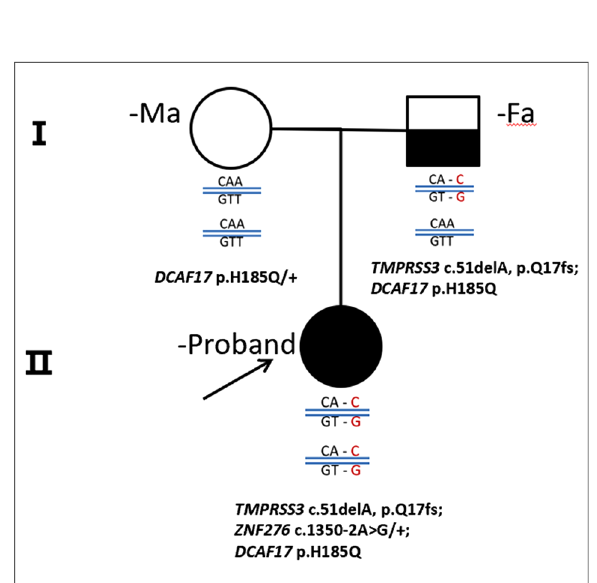
FIGURE 2 A pedigree drawings of the family with non-syndromic hearing imparemt. The proband ’ s parent showed Normal hearing audiograms, while the affected gilrl, carried homozygous mutation, showed profound sensorineural hearing